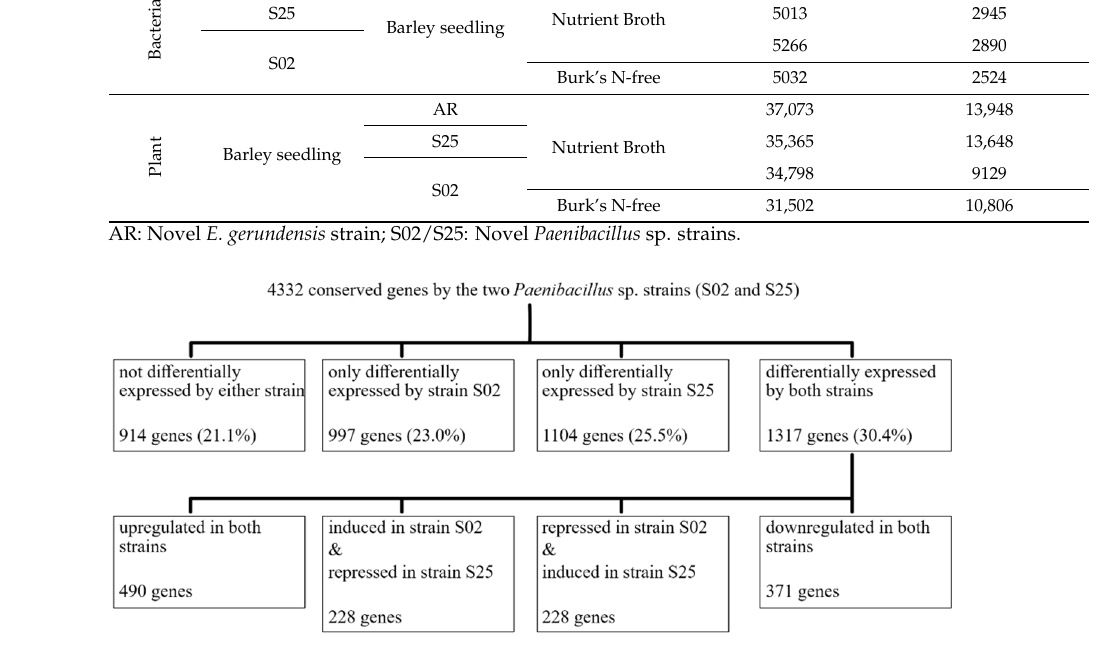
Figure 4. Regulated expressions of 4332 conserved genes of the two Paenibacillus sp. strains (S02 and S25) when co-incubated with barley seedlings in Nutrient Broth. Number of genes and the corresponding percentage of total conserved genes are shown for each category. Despite being genetically closely related (average nucleotide identity = 97.78%), the two strains showed strain- specific responses when interacting with barley seedlings.